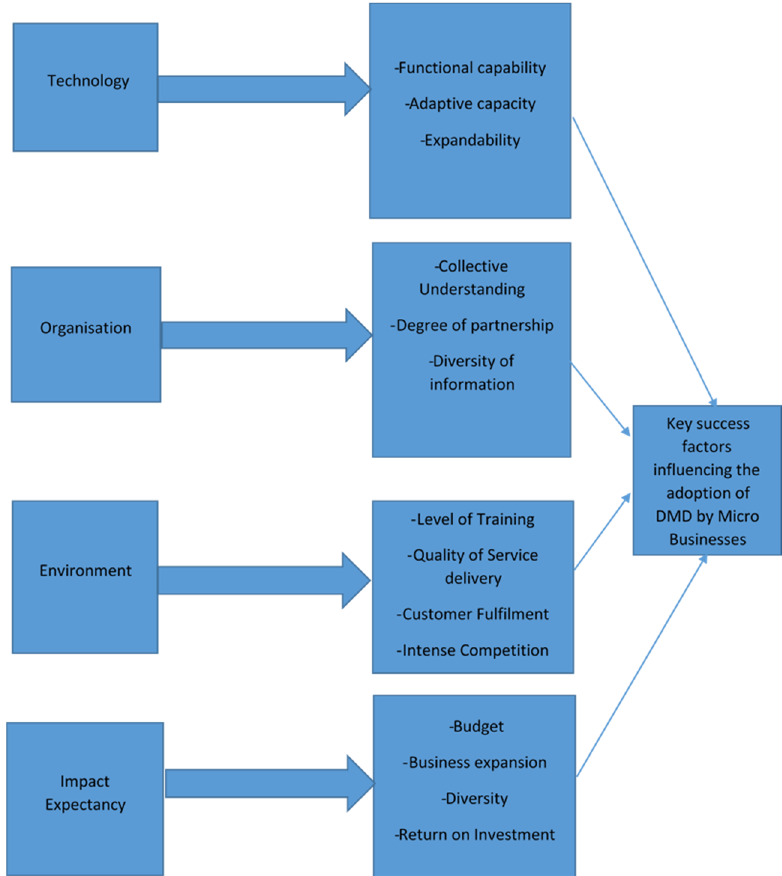
Fig. 3 Framework on crucial success factors in fl uencing the adoption of DMD by microbusinesses.